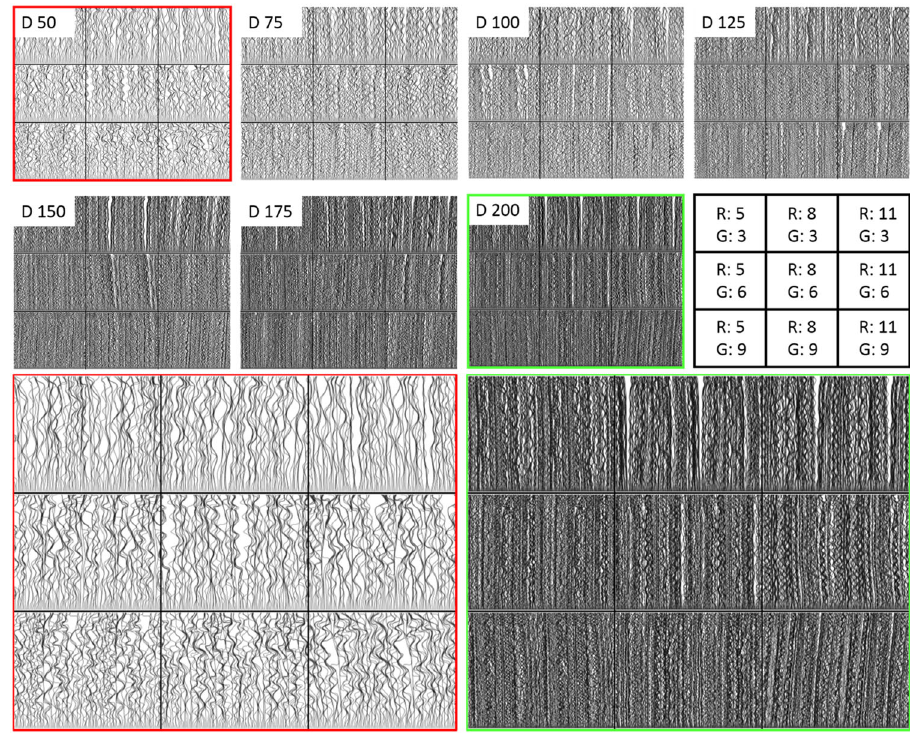
Fig. 2 Representative images from all 63 simulated CNT forest classes. Each block of nine sub-types is grouped by CNT linear density, ranging between D50 and D200 (seven values), representing a density of 50 and 200 CNTs per 10 μ m simulation span, respectively. Each block of nine images is arranged in an order consistent with the key provided on the right side of the middle row of images. Here, R indicates the outer radius in nm (three values), and G is the growth rate coef fi cient of variation (three values). The image blocks for D50 (red border) and D200 (green border) are expanded in the third row to show greater image texture details. The horizontal domain is 10 μ m for each simulation. Note that each image has a replicated texture block in the horizontal direction to demonstrate periodic boundary